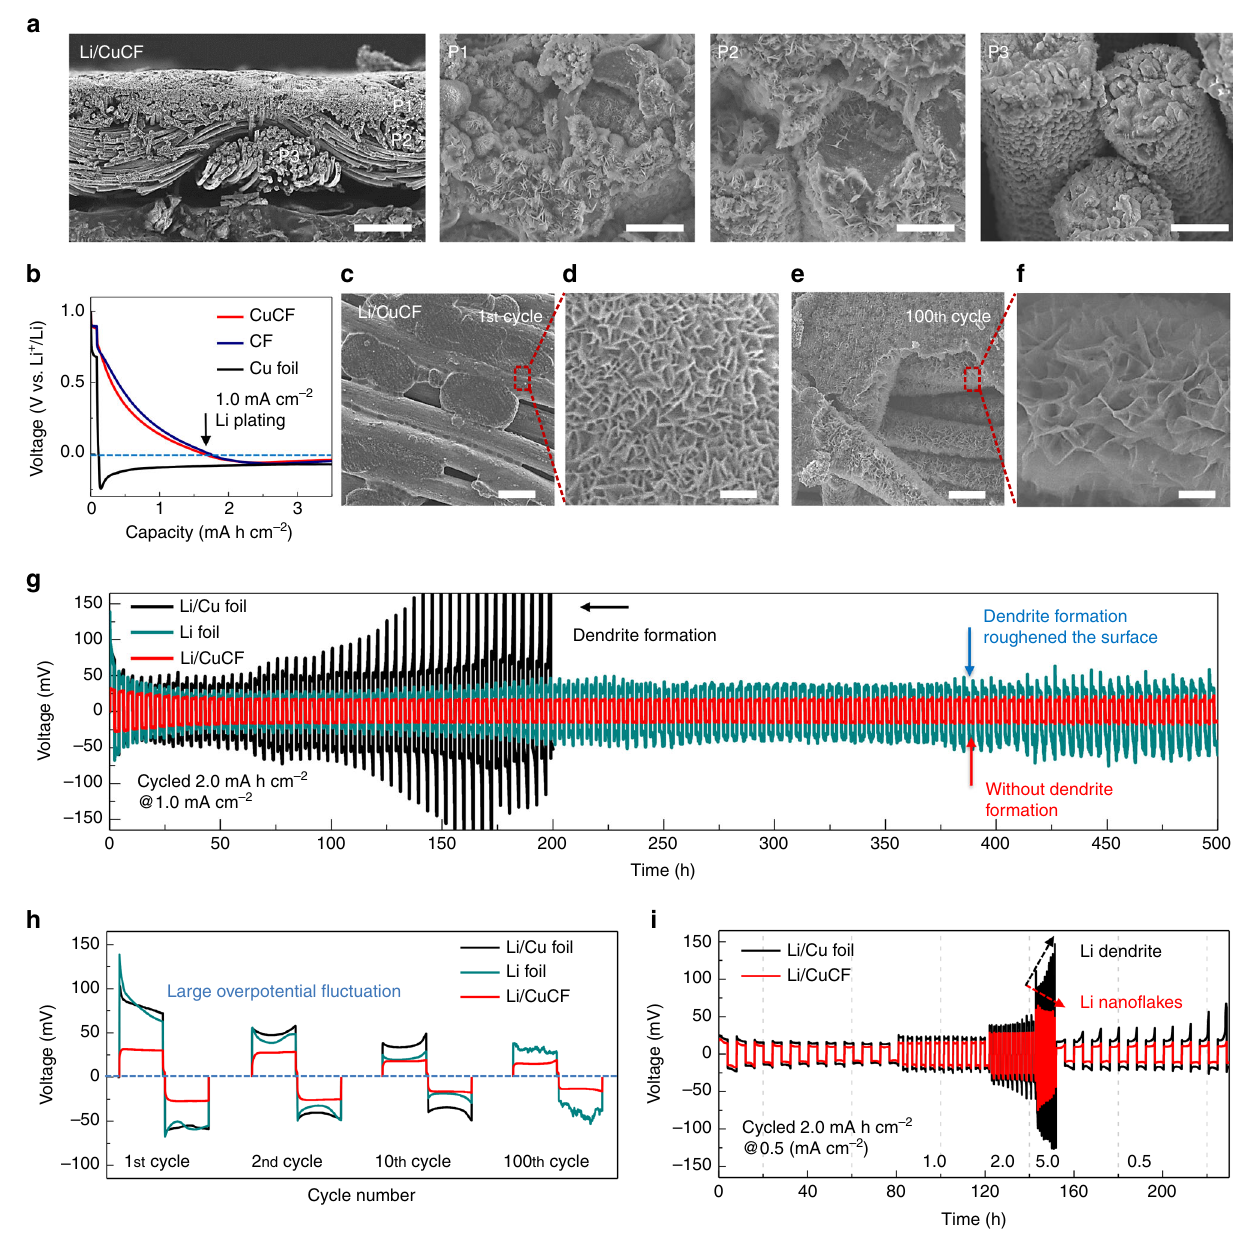
Fig. 2 Plating and striping behavior of lithium anode. a Low and high magni fi cation scanning electron microscopy (SEM) images of lithiated copper- deposited carbon fabric (Li/CuCF) anode in the through-thickness direction (scale bar for a is 100 and 5 µ m, respectively). The upper position (P1), middle position (P2) and lower position (P3) of the fabric are shown. b Nucleation behavior of Li metal onto various hosts (copper-deposited carbon fabric (CuCF), carbon fabric (CF), and Cu foil) at 1 mA cm − 2 during the 1st electroplating process. c – f Low and high magni fi cation SEM images of Li/CuCF anode after the 1st and 100th plating/striping cycle at 1 mA cm − 2 (scale bar for c and e is 100 µ m; scale bar for d and f is 0.2 and 2 µ m, respectively). g Galvanostatic plating/stripping pro fi les in Li/Cu foil, Li foil, and Li/CuCF symmetric cells at 1 mA cm − 2 . h Galvanostatic plating/stripping pro fi le of various Li anodes at 1st, 2nd, 10th, 100th cycle. i Rate performance comparison between Li/CuCF and Li/Cu foil at various current densities from 0.5 mA cm − 2 to 5 mA cm − 2 . The areal capacity of Li metal anodes is 10 mA h cm − 2 ( a ) and 6 mA h cm − 2 ( b – i ),